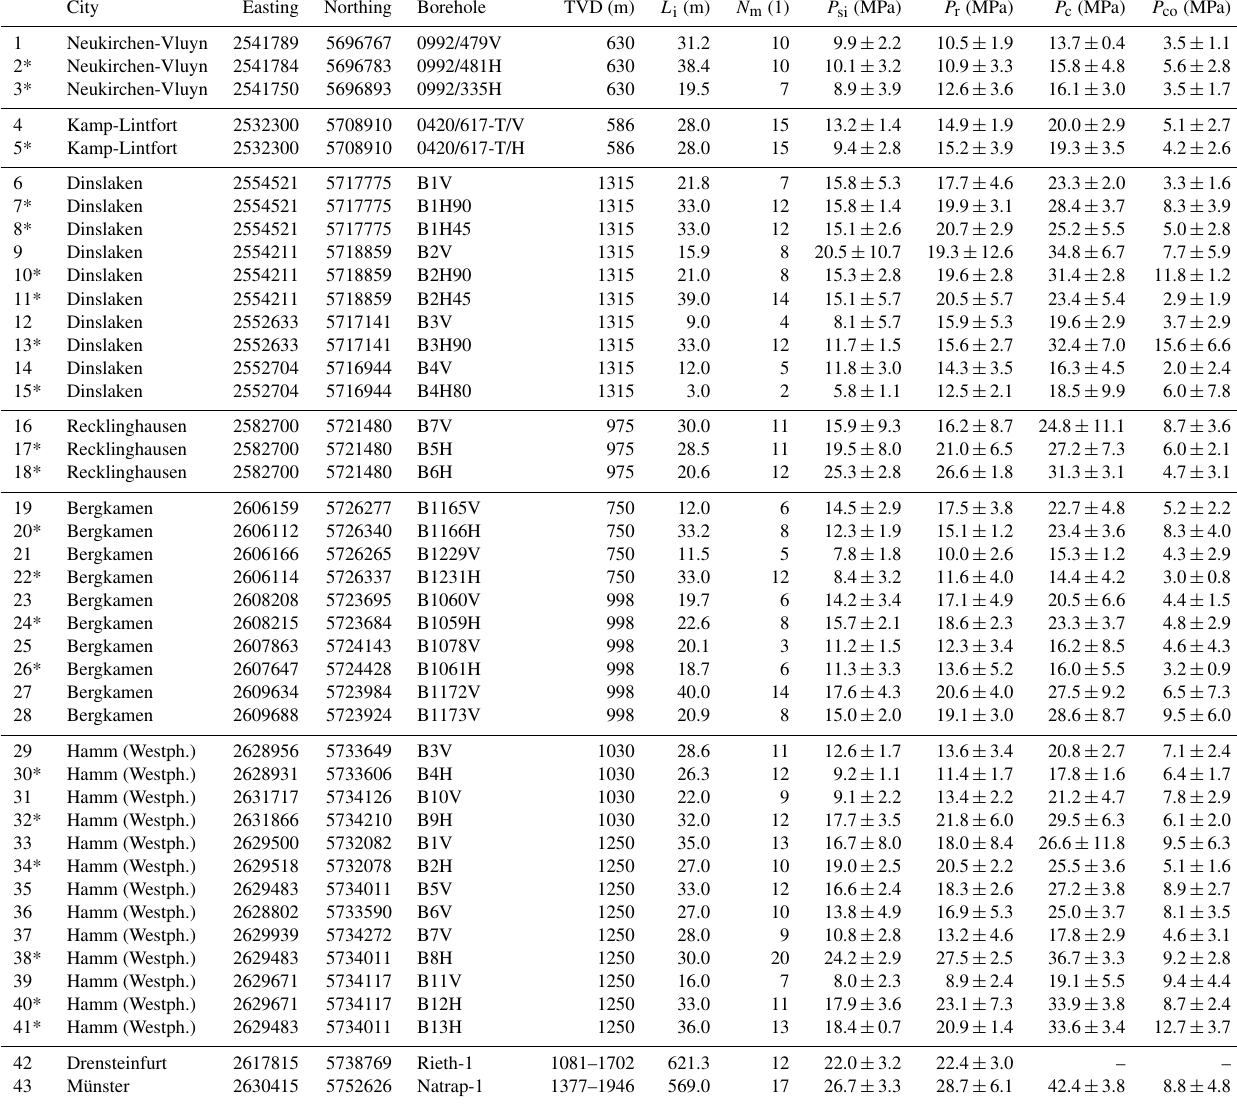
Table 1. Results of hydrofracturing tests performed across the greater Ruhr region (TVD – true vertical depth, L i – length of a test interval, N m – number of stress magnitude tests, P si – shut-in pressure during fracture closure, P r – fracture reopening pressure, P c – breakdown pressure at fracture initiation, P co – rock mass (hydrofracturing) tensile strength). Easting and northing were presented according to the EPSG:31466 geographical